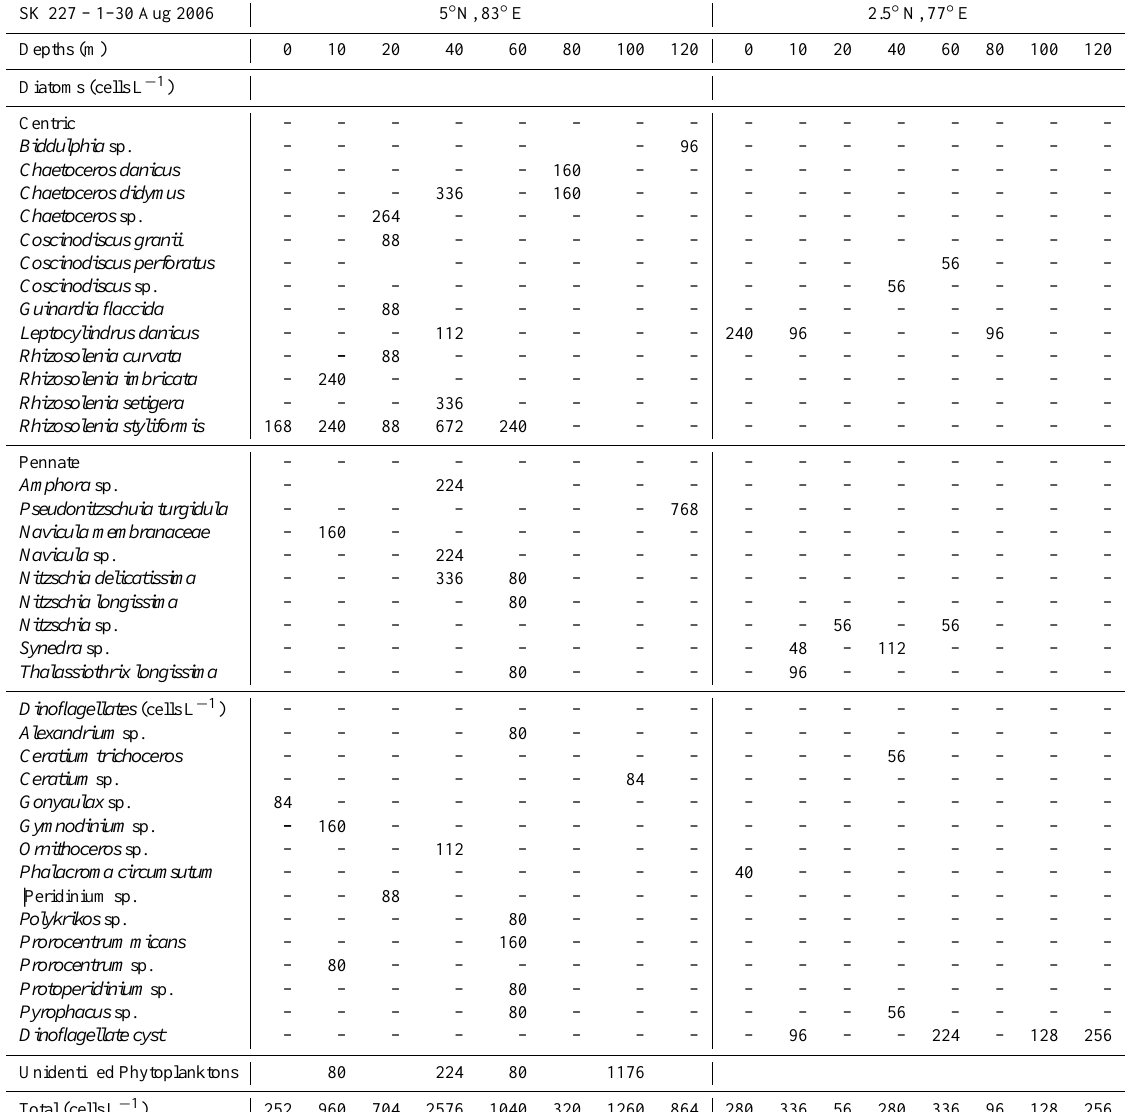
Table 1. Phytoplankton composition and numerical abundance (cellsL − 1 ) at selected stations in the vicinity of SBBT (5 ◦ N; 83 ◦ E) and EIOT (2.5 ◦ N; 77 ◦ E) during August